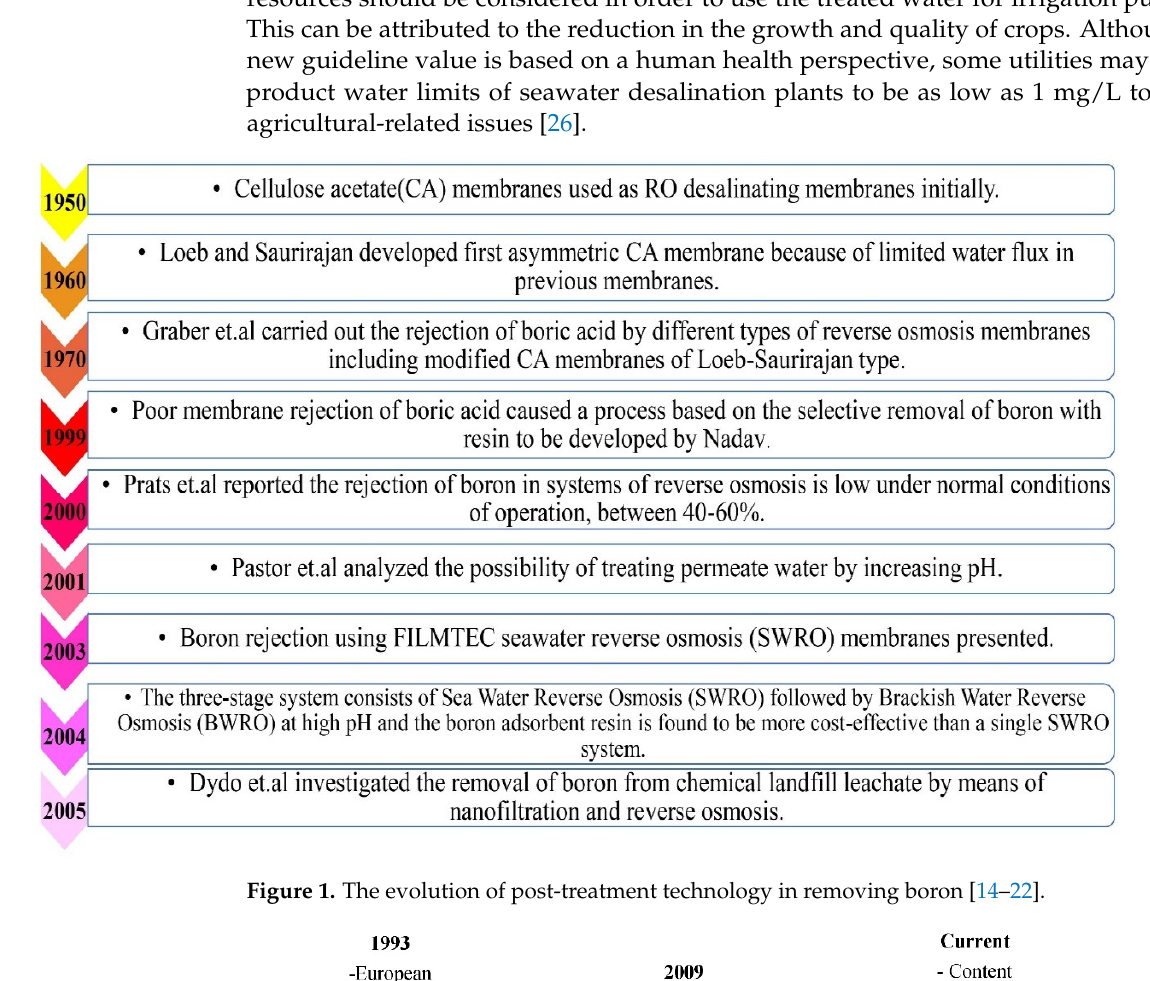
Figure 1. The evolution of post-treatment technology in removing boron [14–22].